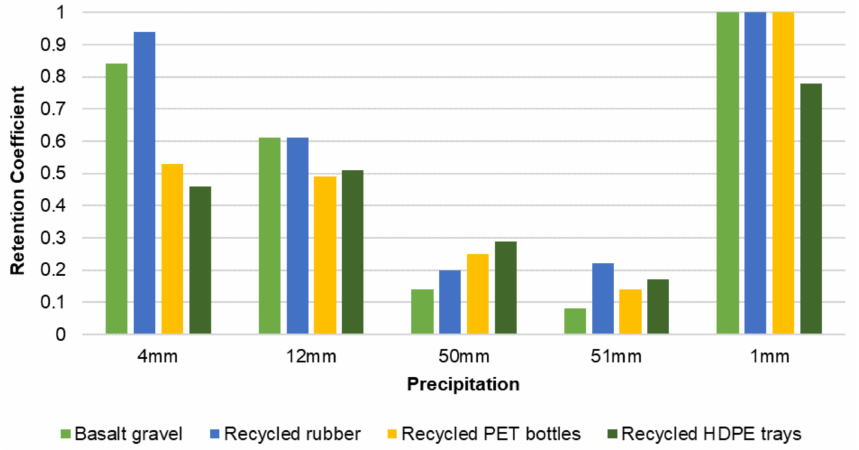
Figure 6. Average behavior of the retention coe ffi cient (C) for typical rain conditions between post-drought and stable cycles.